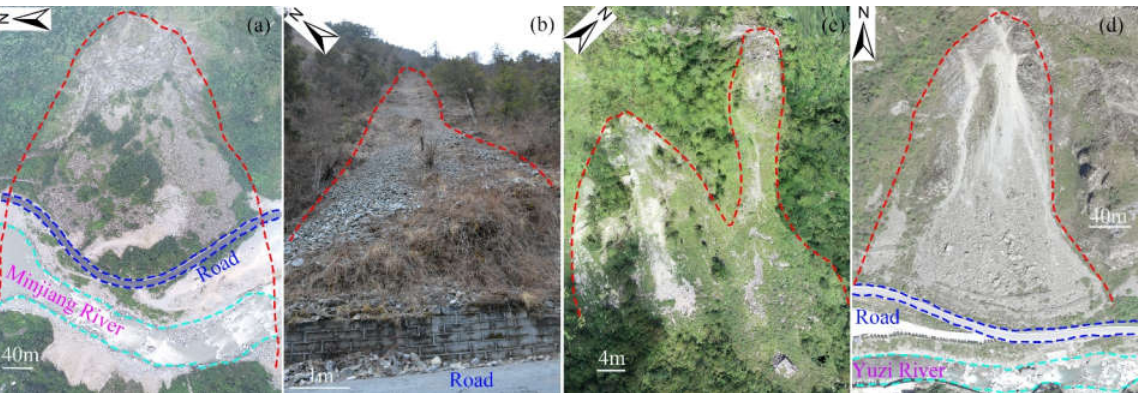
Figure 2. Photos showing landslides in the study region: ( a ) deep-seated rockslide triggered by the Wenchuan earthquake; ( b ) shallow rockslide triggered by road construction; ( c ) rockfall induced by joint cutting; and ( d ) rockfall caused by the Wenchuan earthquake.